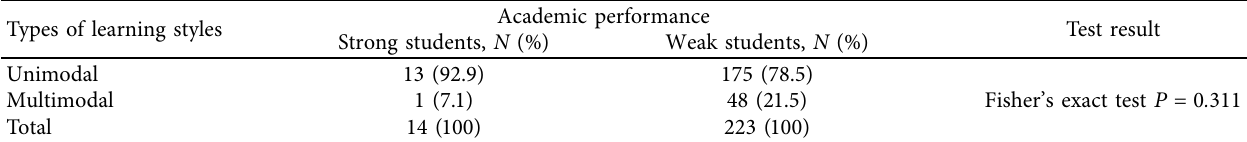
Figure 1: Comparison of strong and weak students in terms of type of learning style. The preferred learning styles in strong and weak students were kinesthetic (57.1%) and auditory (37.2%), respectively. Table 4: Relationship between the learning styles and academic performance of